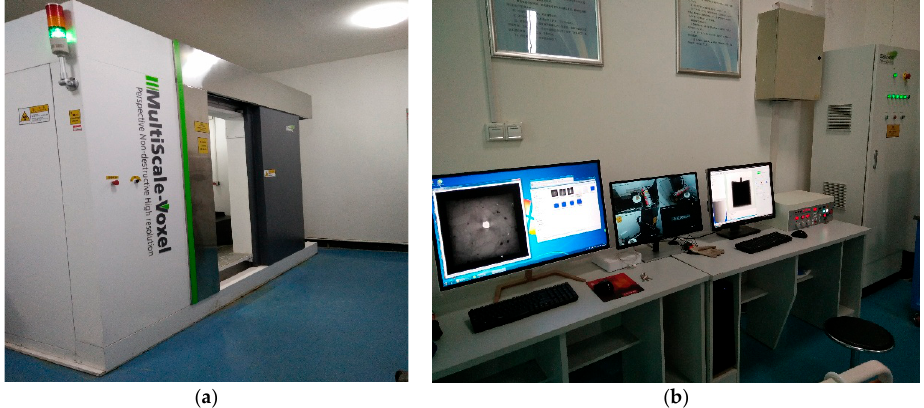
Figure 3. The ICT Equipment. ( a ) The ICT Scanning Equipment; ( b ) The ICT Operating Equipment.